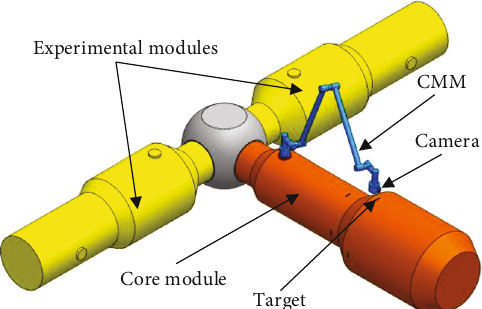
Figure 12: Simulation setup of the on-orbit kinematics calibration.